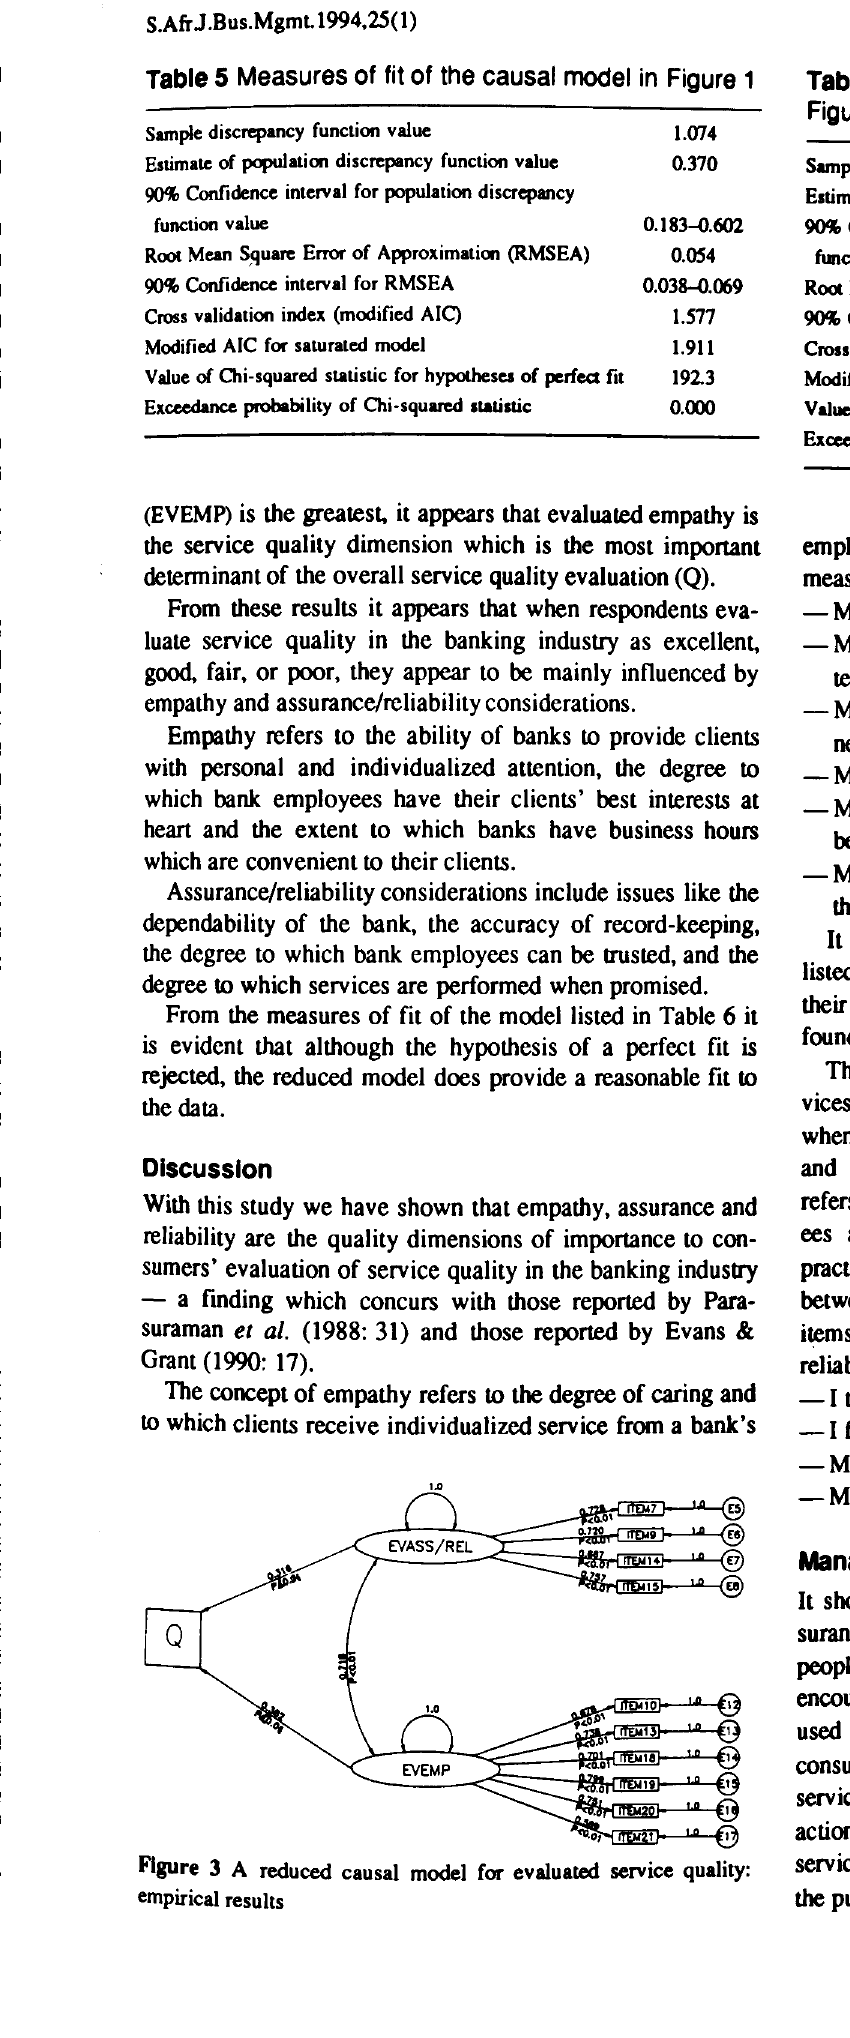
Table 6 Measures of fit of the reduced causal model in Figure